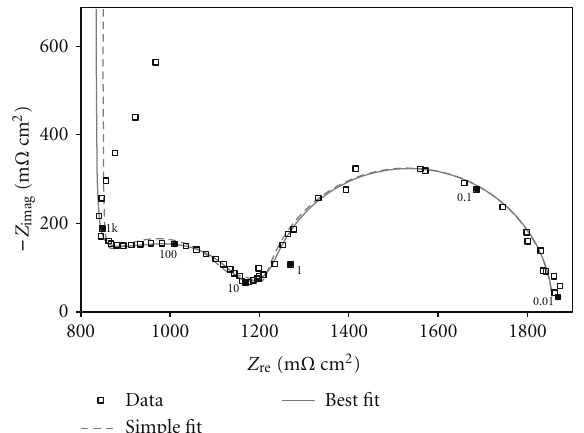
Figure 4: Nyquist plot of a planar fuel cell operating at 800 ◦ C and 52mAcm − 2 and fed with 3% H 2 O, 45% H 2 , and balance N 2 . The cell has been fitted to two di ff erent equivalent circuits: one with three RC circuit s (simple fit) and the other with four (best